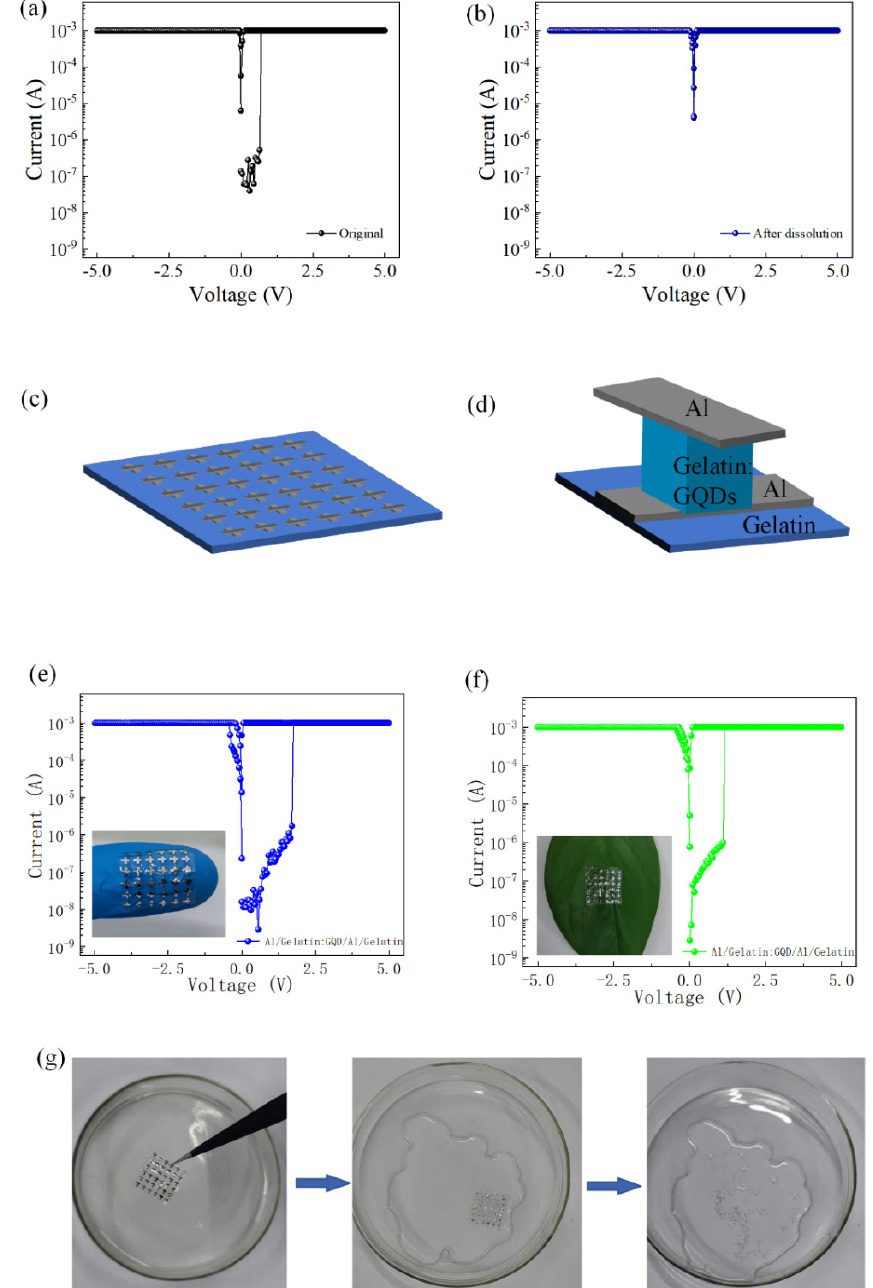
Figure 5. I-V characteristic curve of the Al/Gelatin:GQD/Al/PET device: ( a ) before immersion; ( b ) Al/Gelatin:GQD/Al/Gelatin. ( c ) Schematic diagram of the device after immersion for 15 min; ( d ) enlarged view of the structure of Al/Gelatin: I-V characteristic curve of the GQD/Al/Gelatin ( e ) placed on a finger ( f ) and placed on green leaf. ( g ). The active layer of the device was dissolved in deionized water.